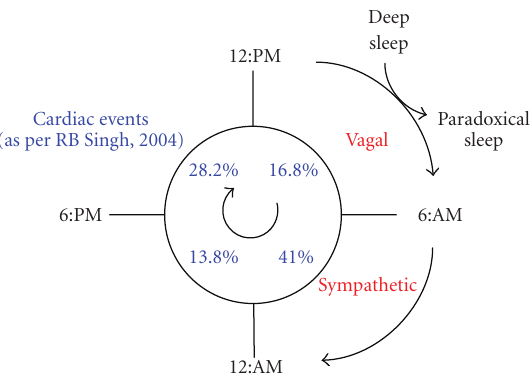
Figure 2: Circadian Rhythms of ACS, Columbus & Tsim Tsoum Concepts. Tsim Tsoum & Coloumbs around the